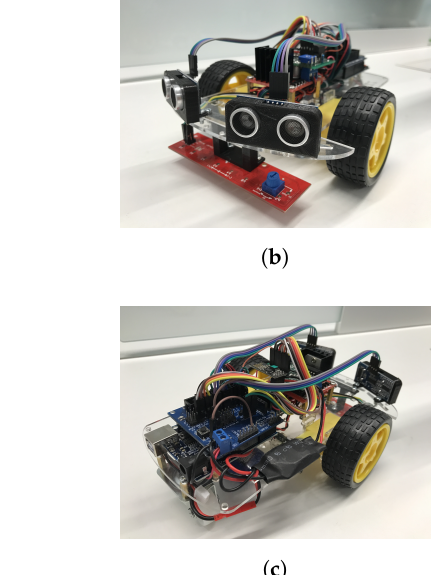
Figure 1. Robot prototype design: Electronic components and design of the robot connections ( a ); Details of the Pyxis Robot ( b , c